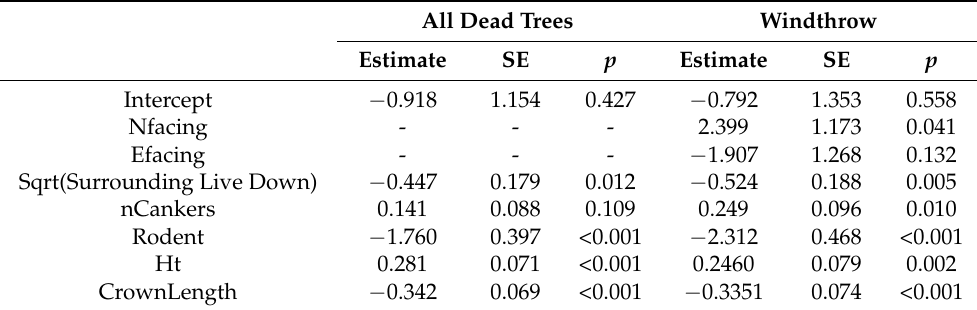
Table 4. Logit-scale coefficients for the best model for all dead trees (windthrow and snags) and windthrow only.